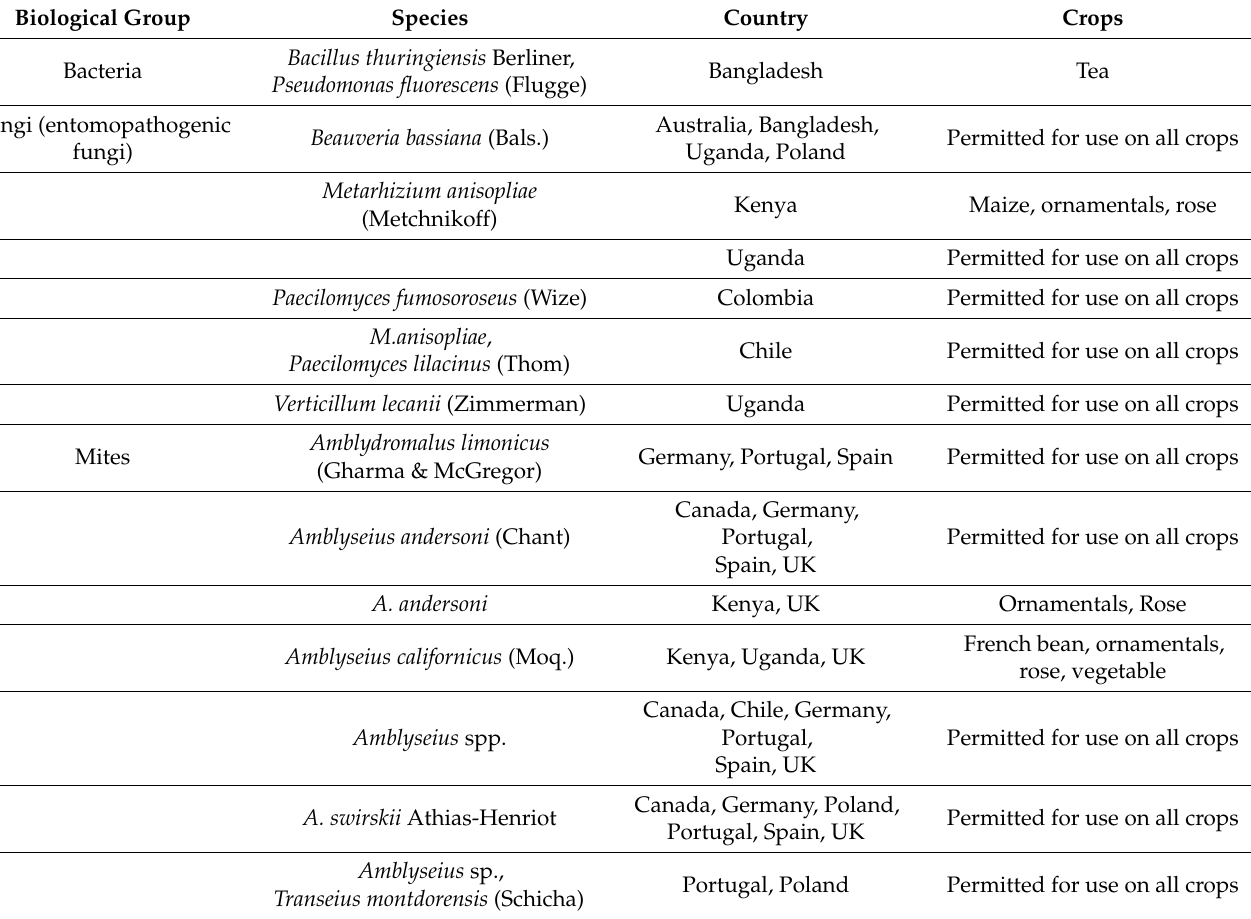
Micro- and macro-organisms used in plant protection products for treatment T. urticae